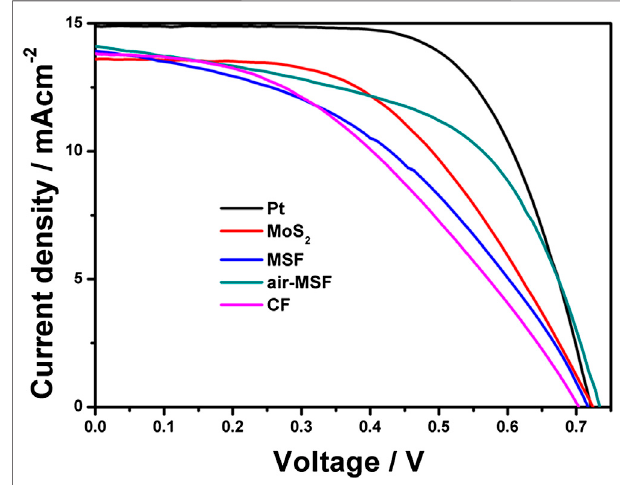
FIGURE 5 | Cyclic voltammetry curves of air-mesoporous silica nano fi ber (MSF), MSF, MoS 2 , and Pt electrodes.